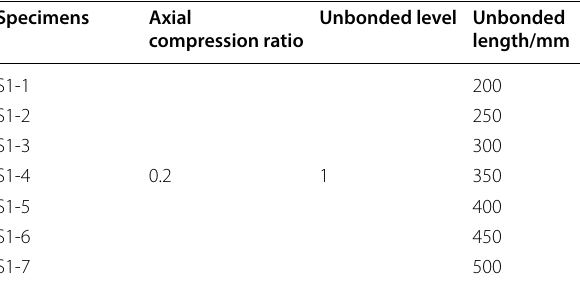
Table 9 Simulated variable parameters of unbonded